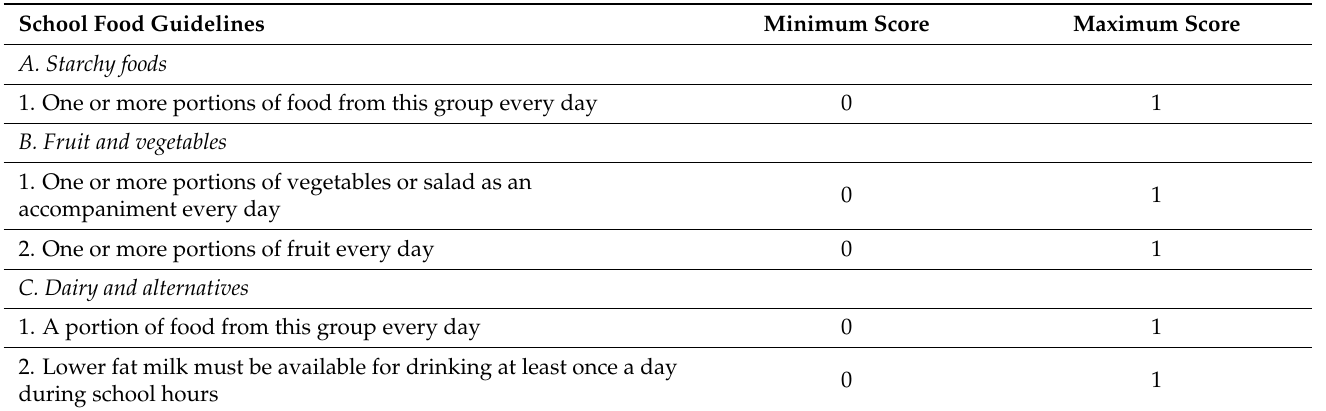
Table 3. Elements of the School Foods Standards used to score lunch meal on an attending and a non-attending club